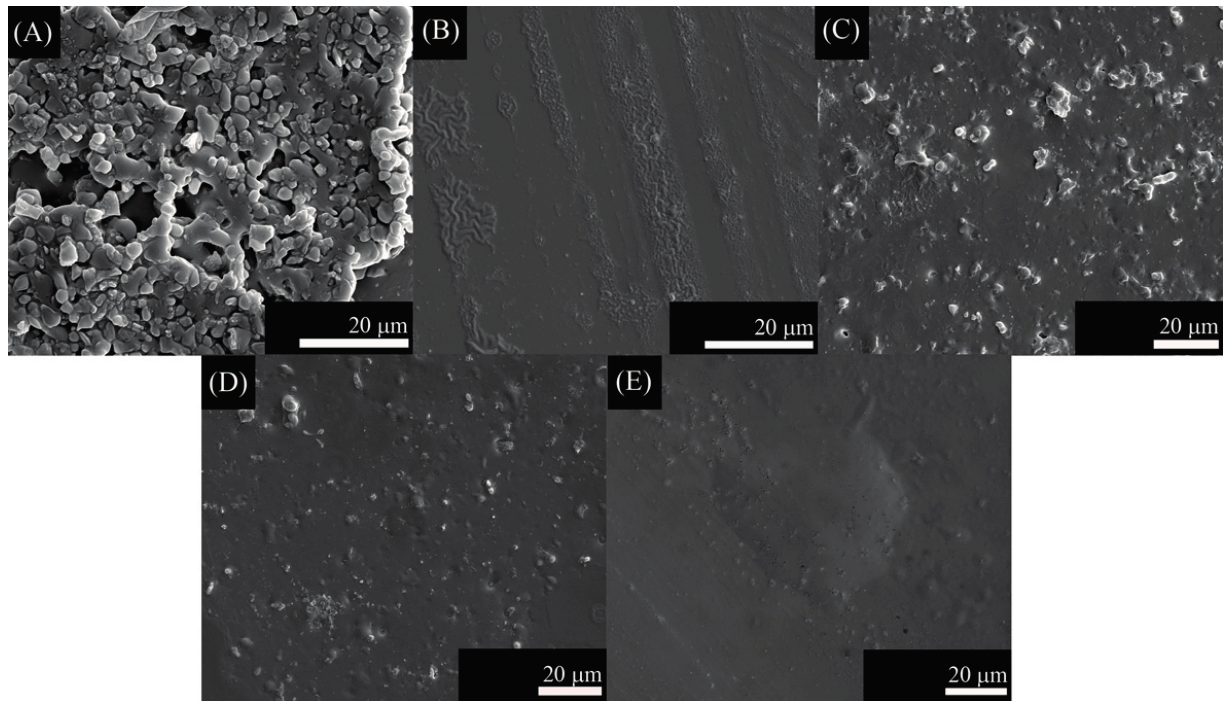
Figure 2. Scanning electronic micrographs of the top surface of ZnO15 coatings on: ( A ) Ti alloy in argon; ( B ) Ti alloy in air; ( C ) Ta in argon; ( D ) Nb in argon; and ( E ) stainless steel in